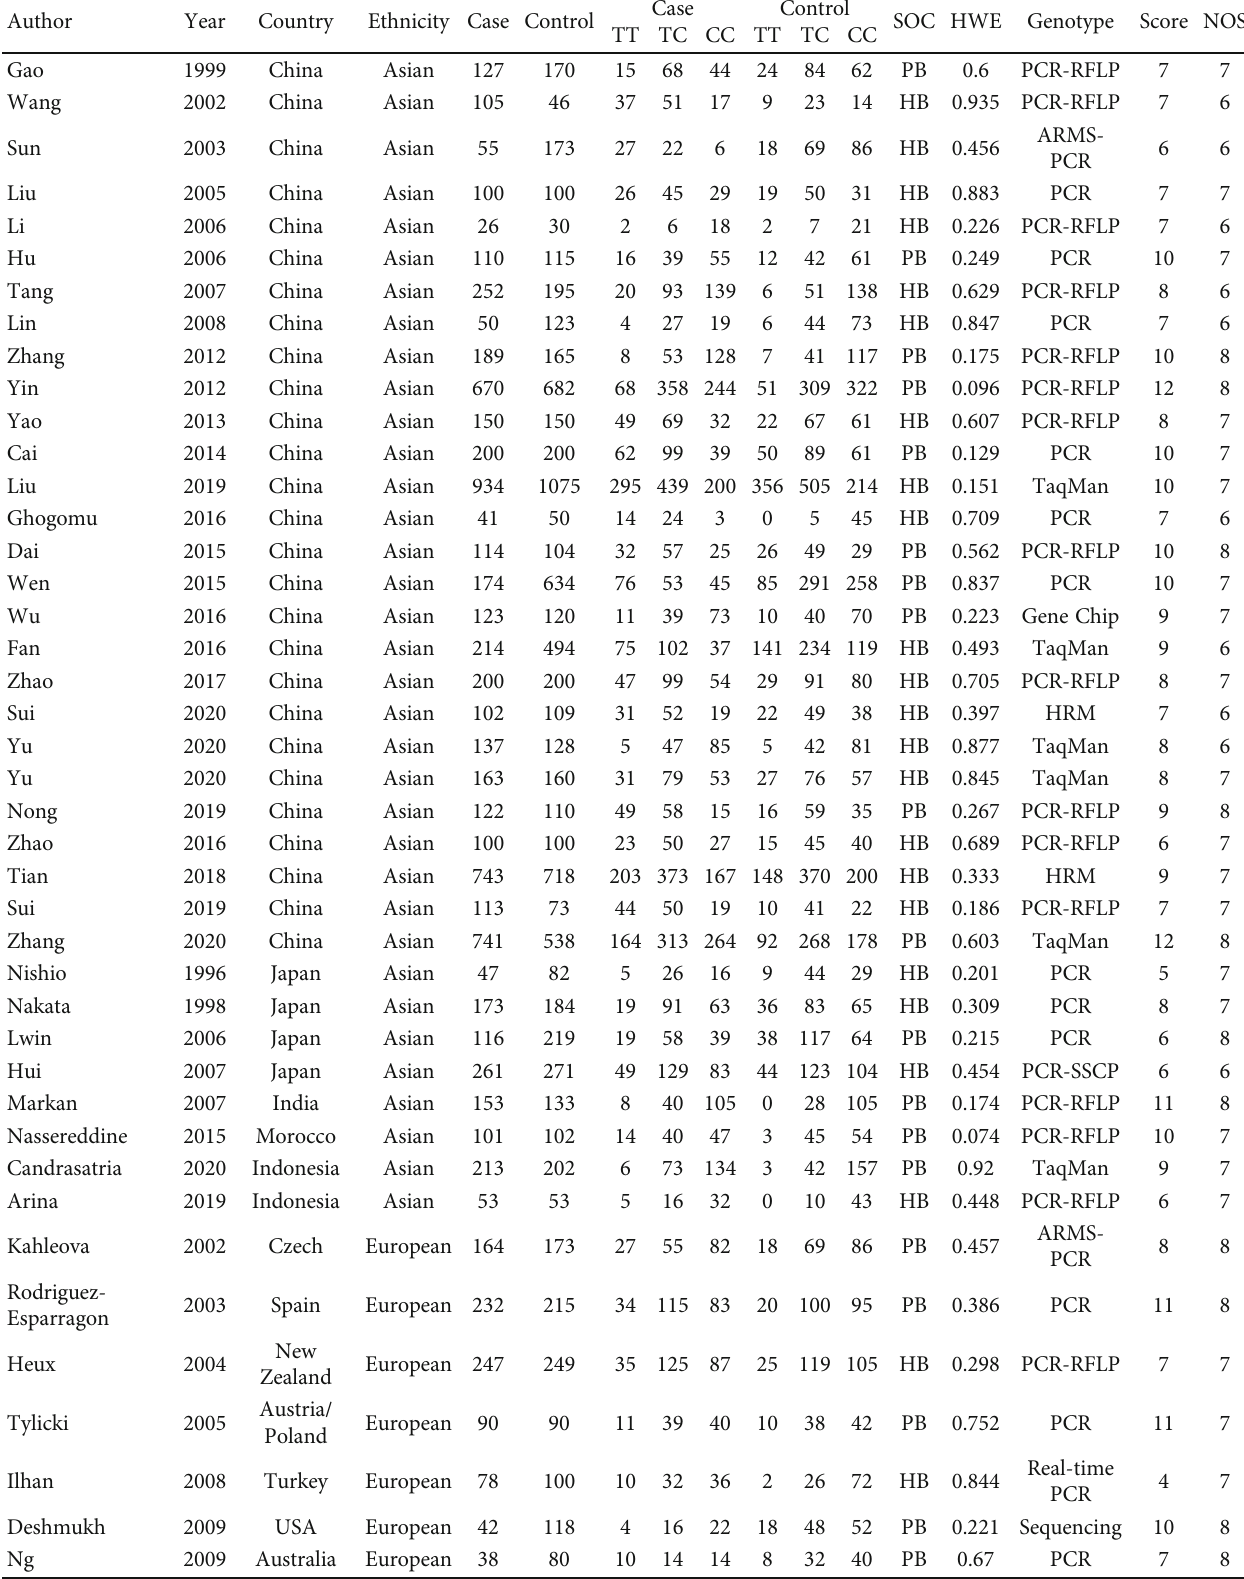
Table 1: Characteristics of studies of MTHFR gene two common polymorphisms and essential hypertension risk included in our meta-